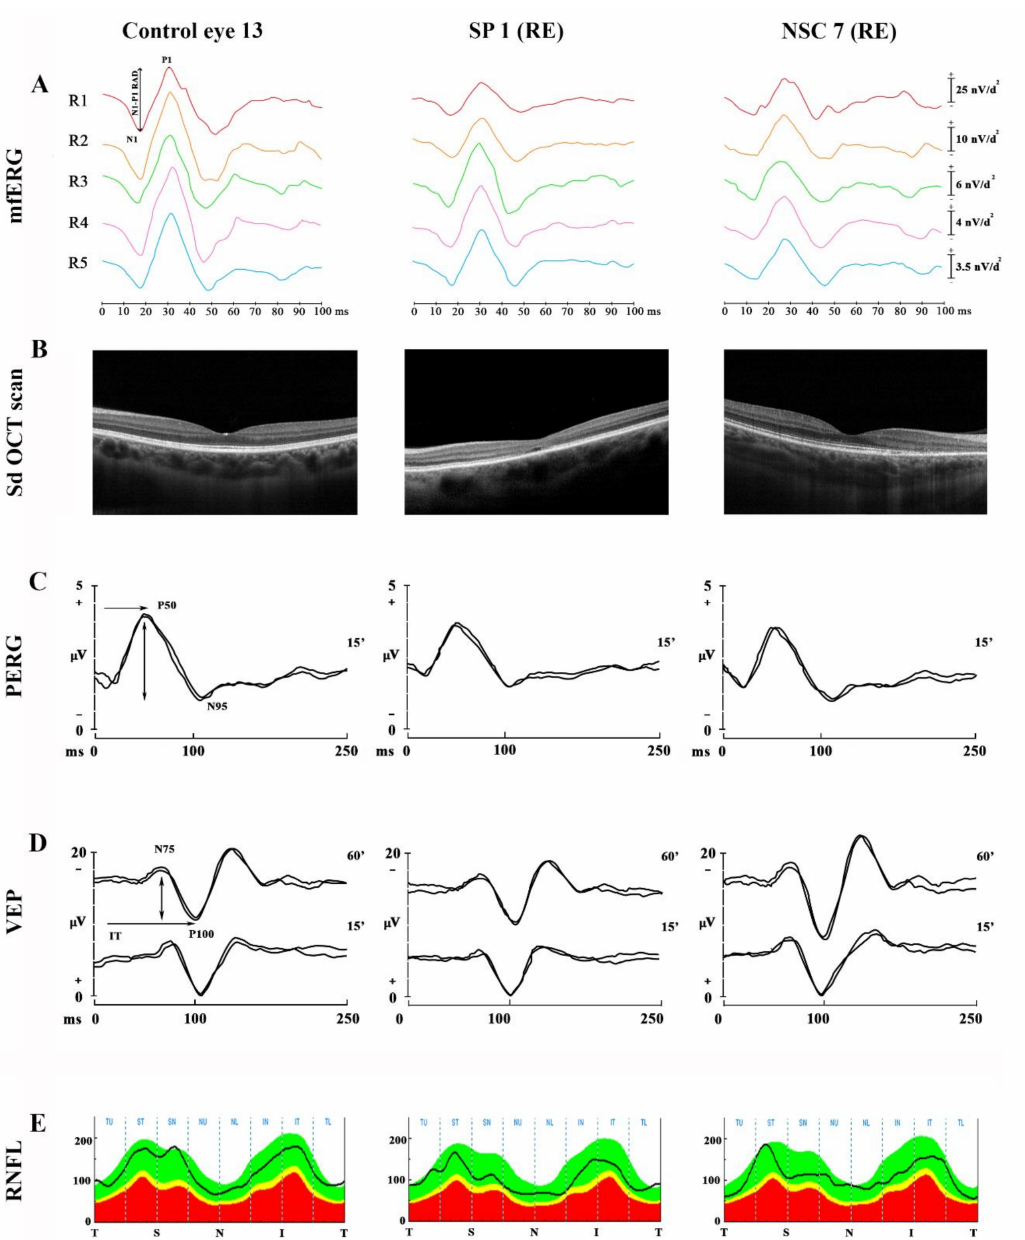
Figure 2. Examples of Multifocal electroretinogram (mfERG) recordings ( A ), Spectral Domain-Optical Coherence Tomog- raphy (Sd-OCT) scans ( B ), Pattern Electroretinogram (PERG) ( C ) , Visual Evoked Potentials (VEP) ( D ) and Retinal Nerve Fiber Layer (RNFL) thickness ( E ) performed in one representative control subject, in one SCA-ATXN1 symptomatic [SP1, right eye (RE)] patient and one not symptomatic [NSC7, right eye (RE] subject. In mfERG examples, the Ring analysis is reported, in which the N1-P1 ( (cid:215) ) response amplitude density (RAD, measured in nanoVolt/degree 2 —nV/deg 2 ) was considered, obtained from five concentric annular retinal regions (rings) centered on the fovea: from 0 to 2.5 degrees (ring 1, R1), from 2.5 to 5 degrees (ring 2, R2), from 5 to 10 degrees (ring 3, R3), from 10 to 15 degrees (ring 4, R4) and from 15 to 20 degrees (ring 5, R5). In PERG and VEP examples, 60 (cid:48) and 15 (cid:48) refers to check edges subtending 60 min (60 (cid:48) ) and 15 min (15 (cid:48) ) of the visual angle for pattern reversal visual stimuli; P50 and N95 refer to the first positive and the second negative peak of PERG recordings, whose P50 implicit time ( → ) and P50-N95 peak-to-peak amplitude ( (cid:215) ) were considered; N75 and P100 refer to the first negative and the first positive peak of VEP recordings, whose P100 implicit time ( → ) and N75-P100 peak-to-peak amplitude ( (cid:215) ) were considered. In the RNFL analysis, T refers to temporal sector, S refers to superior sector, N refers to nasal sector and I refers to inferior sector. The average of the values detected in each sector was